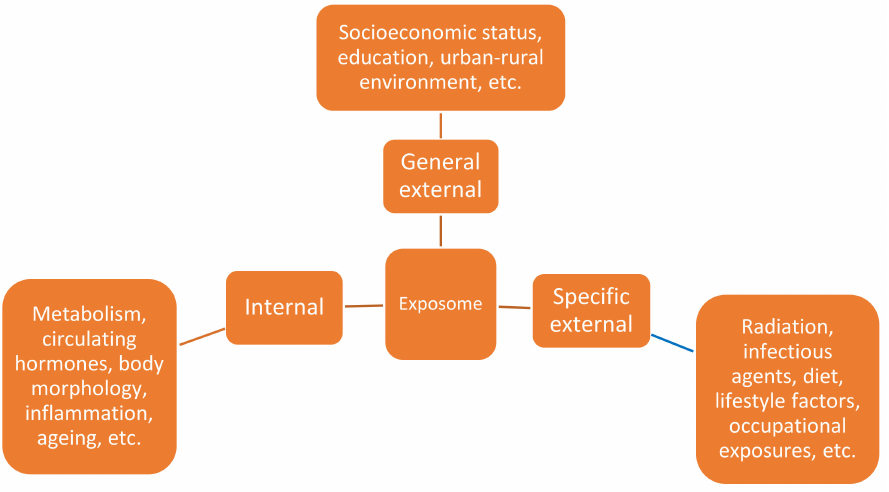
Figure 1. Overview of three different domains of the exposome with examples [17].